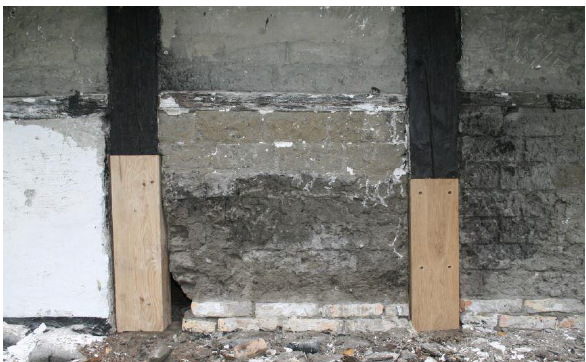
Figure 8. Knowledge of materials is seen in the adobes laid on baked bricks. Repair of post could have been made with reused timber for reasons of sustainability (Photographer Søren